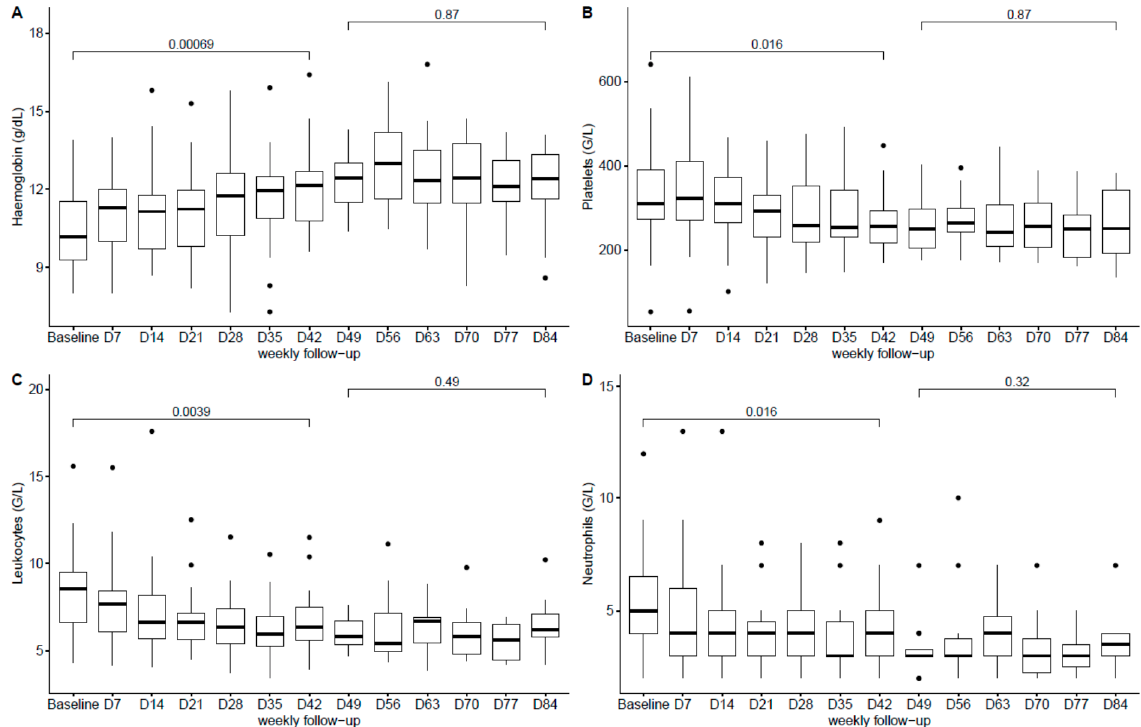
Figure 1. Boxplot of the haematological parameters (( A ): Haemoglobin, ( B ): Platelets, ( C ): Leukocytes, ( D ): Neutrophils) during Tedizolid therapy. Each box represents median, interquartile range, largest, smallest and outside (point) values.